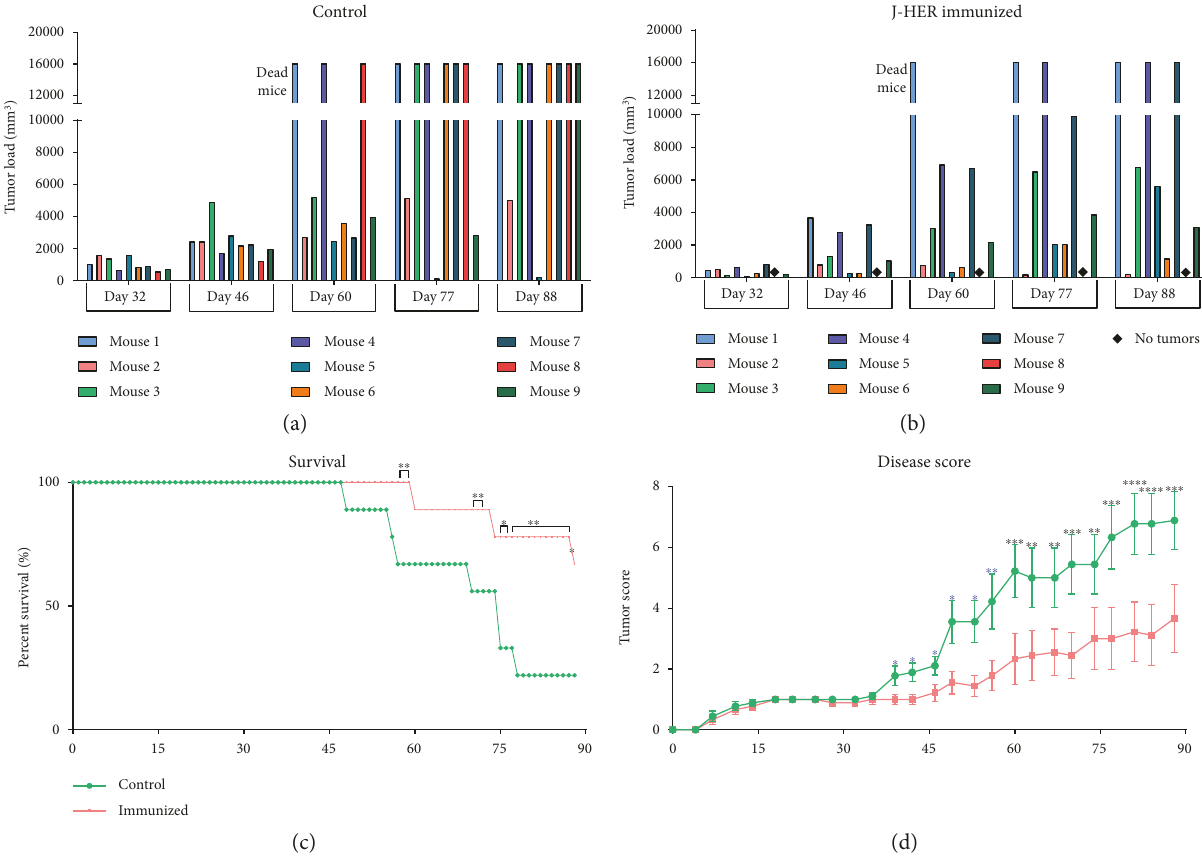
Figure 4: J-HER treatment of TUBO cell-challenged mice. Mice were challenged with 2.5 × 10 [7] TUBO cells in each of two sites and then immunized with HBSS in Montanide ISA-51 adjuvant (control n = 9 ) or J-HER in adjuvant (vaccine n = 9 ) one week later and at two-week intervals thereafter. Data is presented with respect to day after tumor challenge. (a) The average tumor load by volume for untreated mice. Mice that died during the trial are indicated by values of 16,000 and mice with no tumors are indicated by a diamond. (b) The average tumor load by volume for J-HER-treated mice, depiction as for panel (a). (c) Kaplan-Meier plot of survival on days shown after tumor challenge. (d) The disease score (calculated as de fi ned in the Methods). ( ∗ p < 0 05 ; ∗∗ p < 0 01 ; ∗∗∗ p < 0 001 ; ∗∗∗∗ p < 0 0001